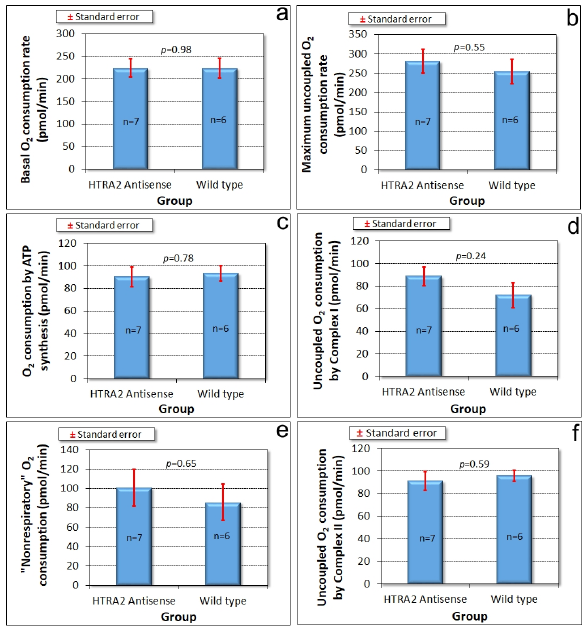
Figure 5. Mitochondrial respiration is unaffected by HTRA2 knockdown. Seahorse respirometry was conducted in the indicated number (n) of independent experiments on wild type (AX2) cells and cells of four different HTRA2 knockdown strains (antisense construct copy numbers ranging from 96 to 163). Basal respiration ( a ) and its components attributable to adenosine triphosphate (ATP) synthesis ( c ) and “nonmitochondrial” respiration ( e ) were unaffected. The maximum respiration rate by carbonyl cyanide 3-chlorophenol hydrazone (CCCP)-uncoupled mitochondria ( b ) and its components attributable to Complex I ( d ) and Complex II activity ( f ) were not significantly affected. The copy number of the antisense construct had no significant effect on any of the parameters of respiration (Pearson correlation coefficient, n=13, p >0.05).